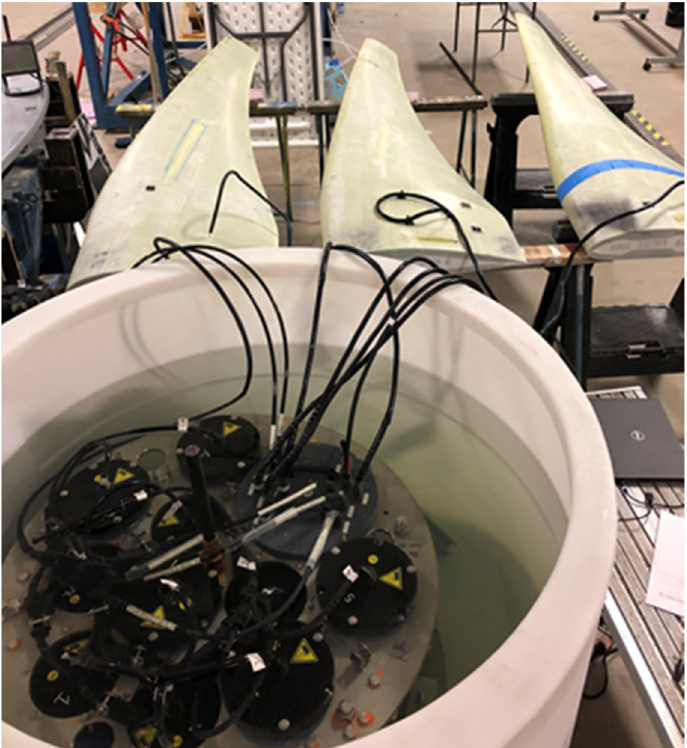
Figure 10. Three thermoplastic blades connected to the NDAQ, and the NDAQ submerged in